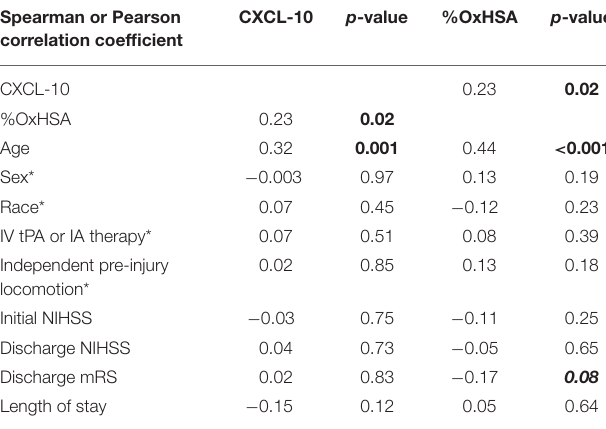
TABLE 2 | Multivariate predictors of a favorable discharge mRS ≤ 2.